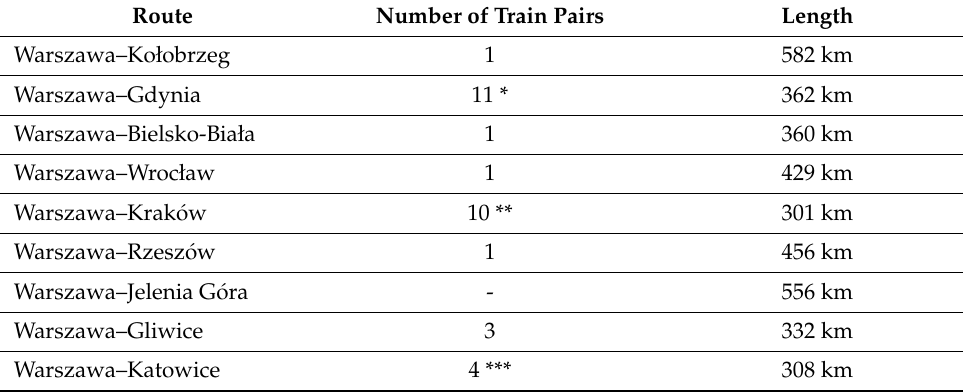
Table 3. List of supported routes with length.